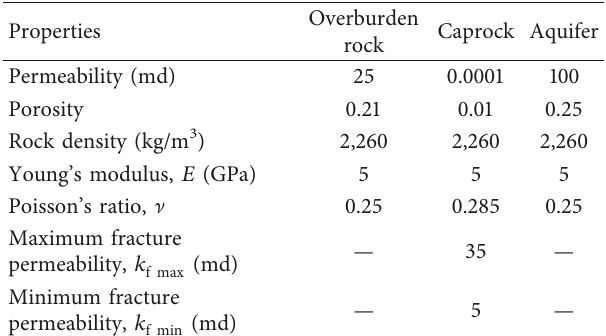
Table 1: Hydraulic and geomechanical properties for homoge- neous model.